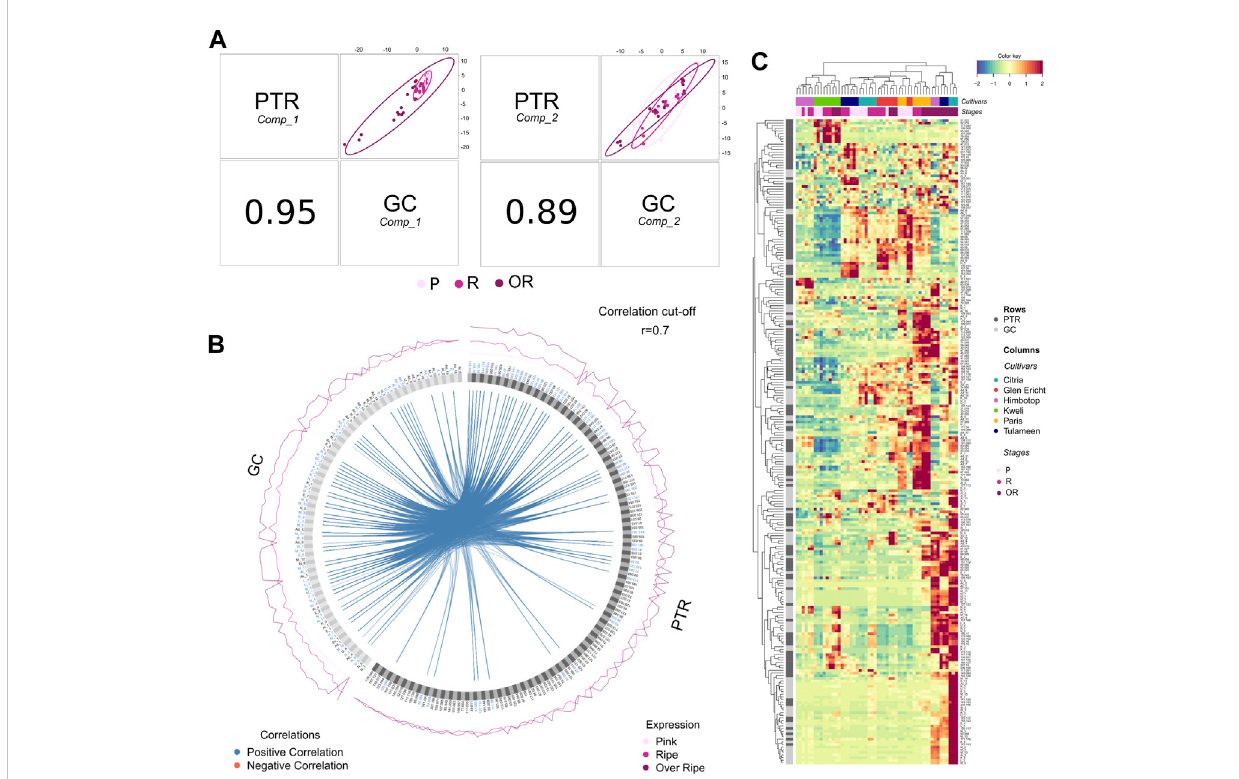
FIGURE 3 Complementaritybetween SPME/GC-MSand PTR-ToF-MS headspace VOCassessmentsde fi ned byapplying theDIABLO multi-blockdiscriminant analysis. Plot (A) depicts a global overview of the correlation structure at the component level. This function allows for the plotting of the components (component1andcomponent2)acrossthedifferentdatasetsforagivendimension.Plot (B) reportsthecorrelationcircularplotbetweenVOCsassessed bySPME-GC-MSandPTR-ToF-MSbuiltbasedonasimilaritymatrix.Acut-offlevelof0.7wasarbitrarilyincludedtovisualizecorrelationcoef fi cients above this threshold. Plot (C) reports the “ Clustered Image Map ” representing the multi-omics molecular signature expression for each sample. Each cell ’ s colour is based on the values of the similarity matrix performed on the two VOC